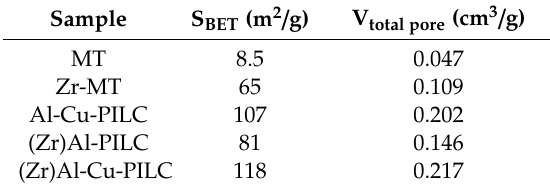
Table 3. Specific surface areas and pore characteristics of MT and their respective catalysts.